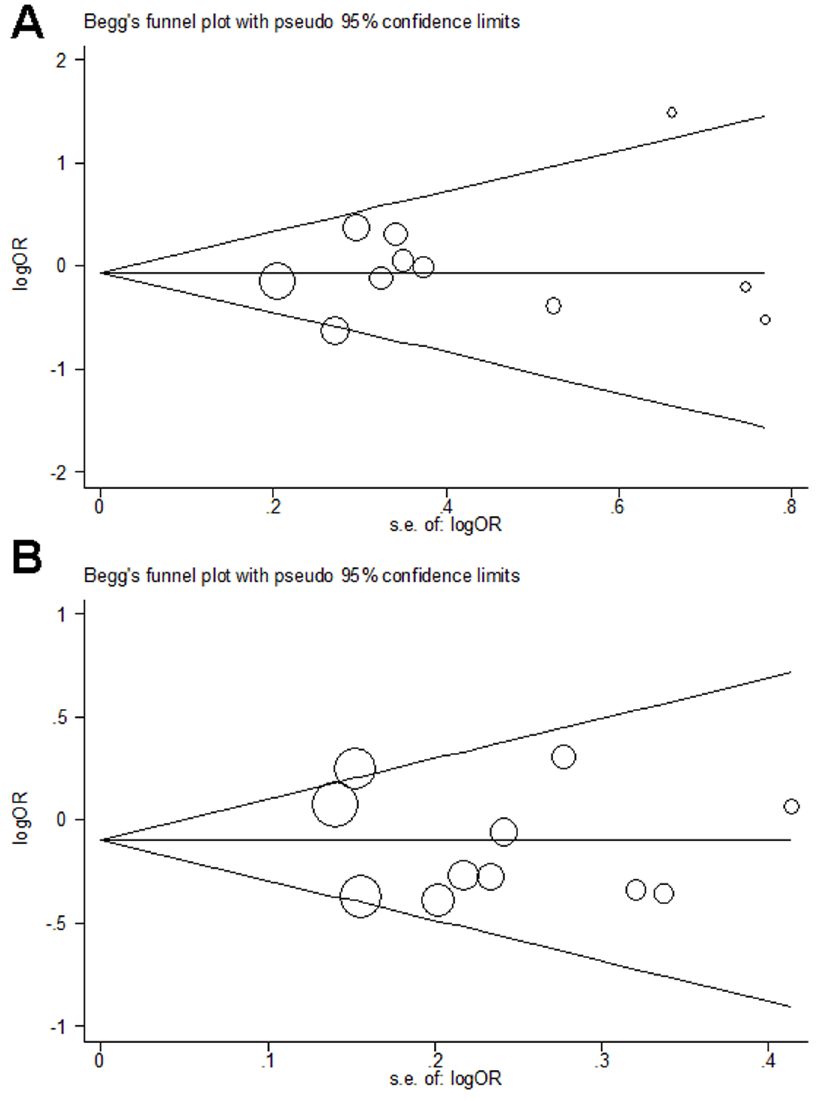
Figure 4. Begg’s funnel plots of Arg399Gln polymorphism and the risk of DTC for publication bias test. Each point represents a separate study for the indicated association. Log (OR), natural logarithm of OR. Horizontal line, mean effect size. (A) Recessive model. (B) Dominant model.